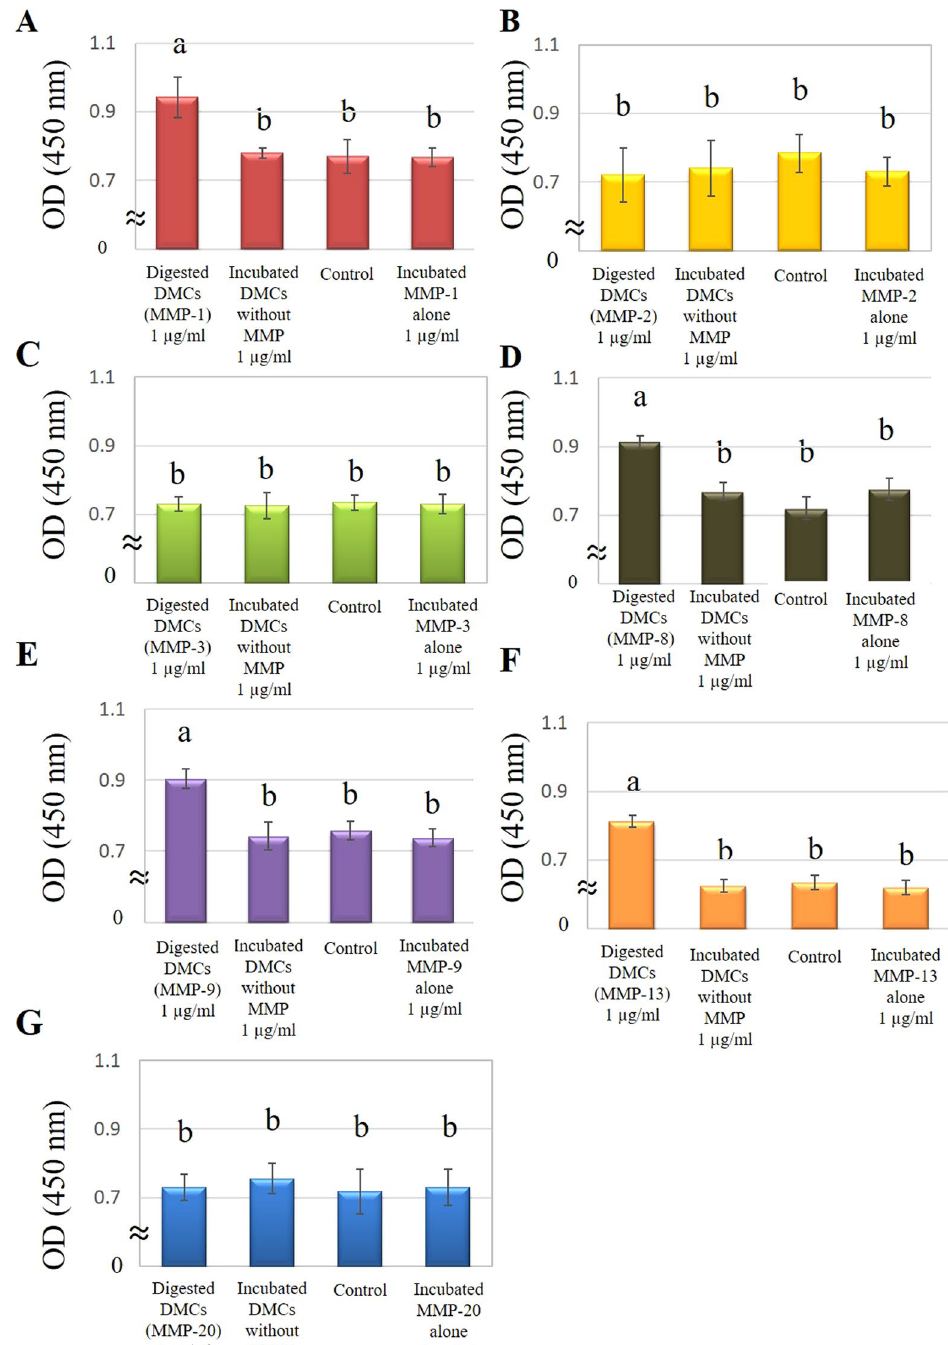
Figure 4. Effects of 1 µ g/ml of dentin matrix components (DMCs) treated with matrix metalloproteinase (MMP)-1 ( A ), MMP-2 ( B ), MMP-3 ( C ), MMP-8 ( D ), MMP-9 ( E ), MMP-13 ( F ) and MMP-20 ( G ) on cell proliferation of rat primary pulp cells. Pulp cell proliferation was promoted by 1 µ g/ml of DMCs treated with MMP-1 ( A ), -8 ( D ), -9 ( E ), or -13 ( F ), compared with incubated DMCs without the addition of MMPs (p < 0.05). Significant differences were not observed with 1 µ g/ml DMCs treated with other MMPs, MMPs incubated alone or at lower concentrations (0.01–0.1 µ g/ml) of the above mentioned MMPs (Supplementary Figure 6). Groups with similar lower-case letters (i.e., a and b) are not significantly different. Data represent five independent